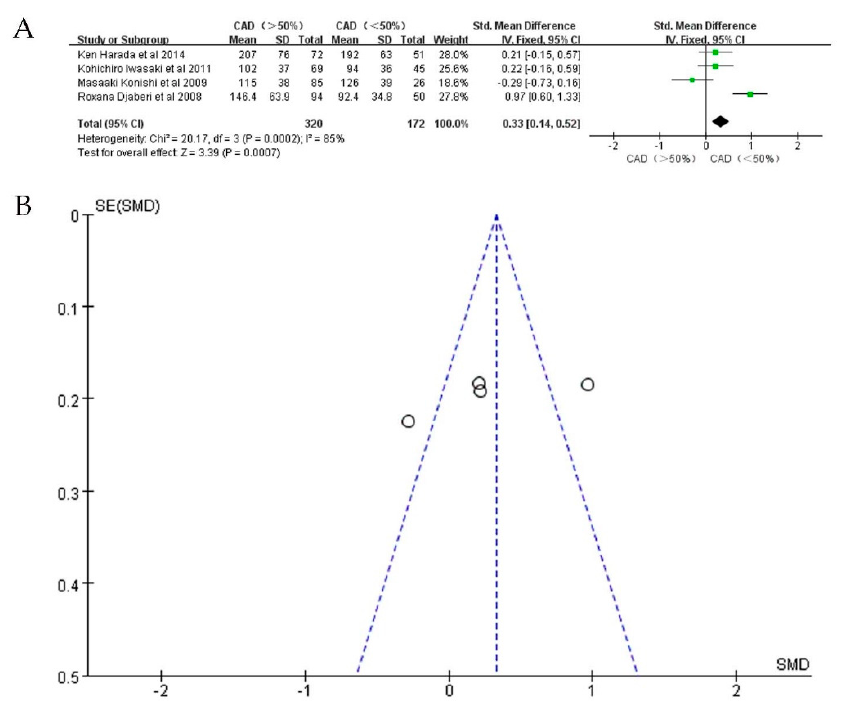
Figure 5. SMD of EAT volume between patients with severe CAD and mild / moderate CAD. ( A ): Forest plot; ( B ): funnel plot.